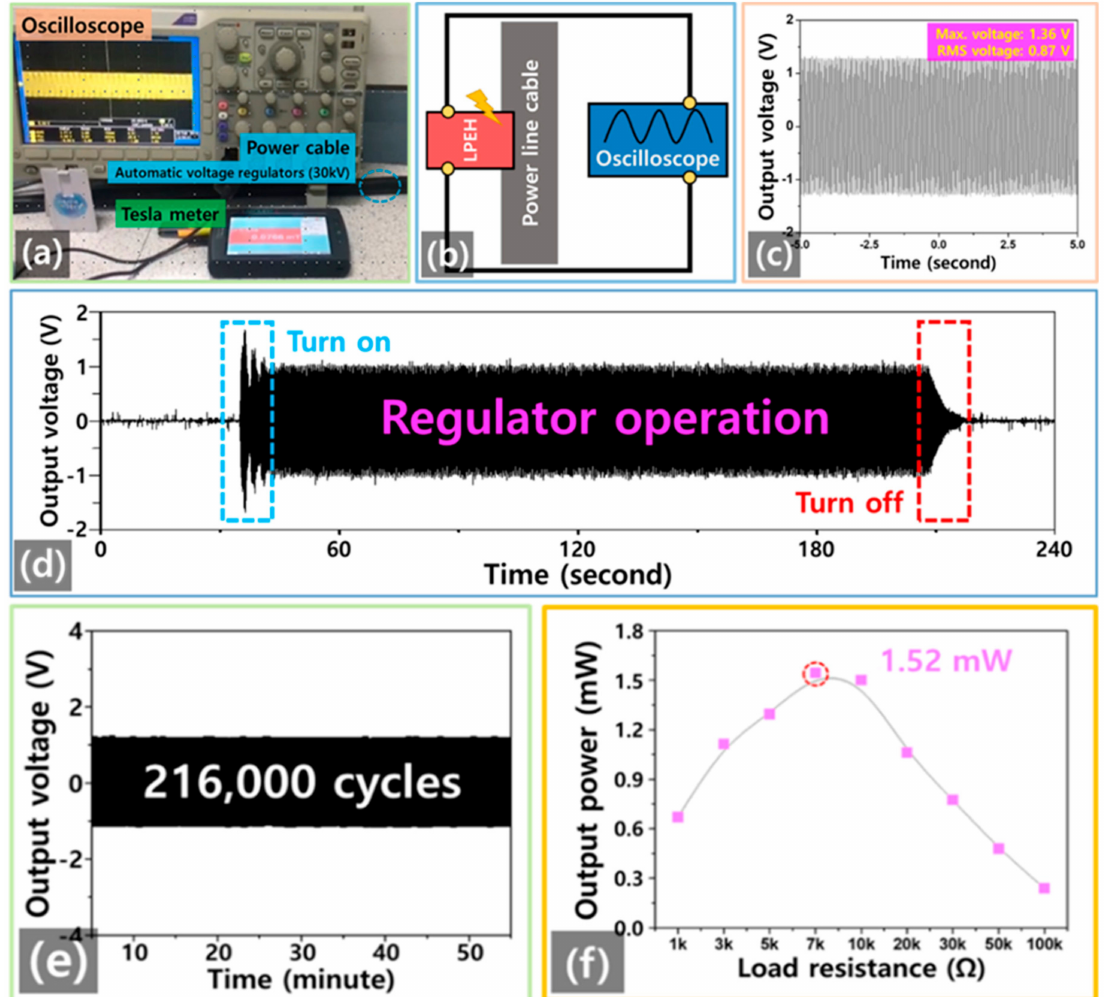
Figure 5. ( a ) Experimental setup to test the energy-harvesting performance from the power-line cable of an automatic voltage regulator (30 kV). ( b ) Diagram of the energy-harvesting circuit with the LPEH. ( c ) Open-circuit voltage of the LPEH from the magnetic field of a power-line cable. ( d ) Open-circuit voltage of the LPEH under a regulated turn-on and -off condition. ( e ) Open-circuit voltage of the LPEH for a durability test over 216,000 cycles performed in a weak magnetic field of 78 µ T. ( f ) Output power of the LPEH in the magnetic field of a power-line cable as a function of the load resistance (range of 1 k Ω to 100 k Ω